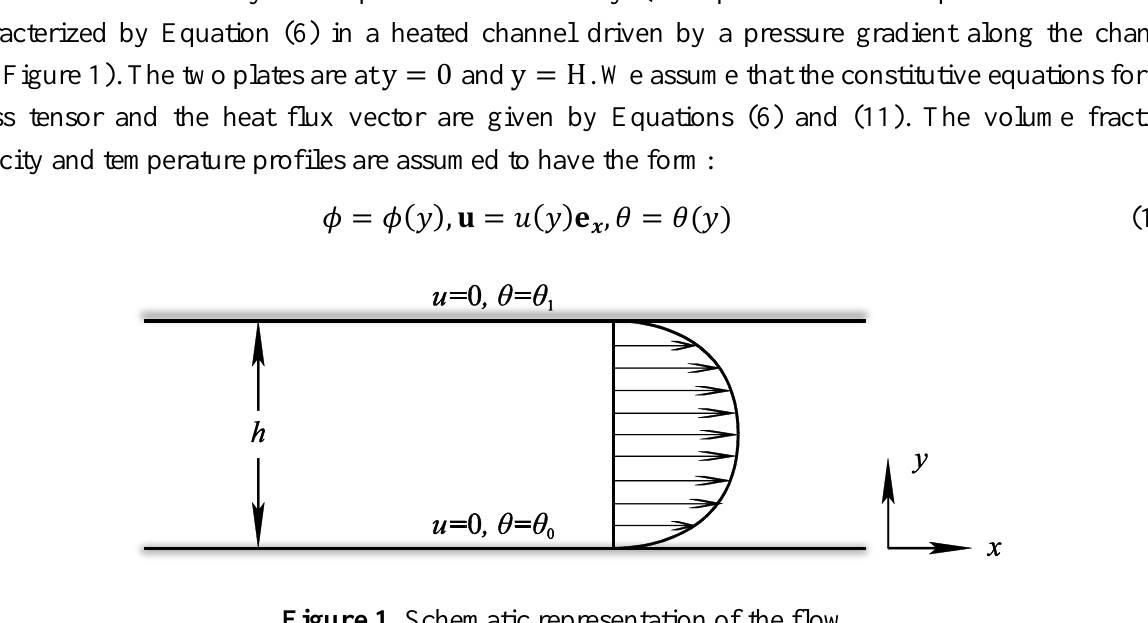
Figure 1. Schematic representation of the